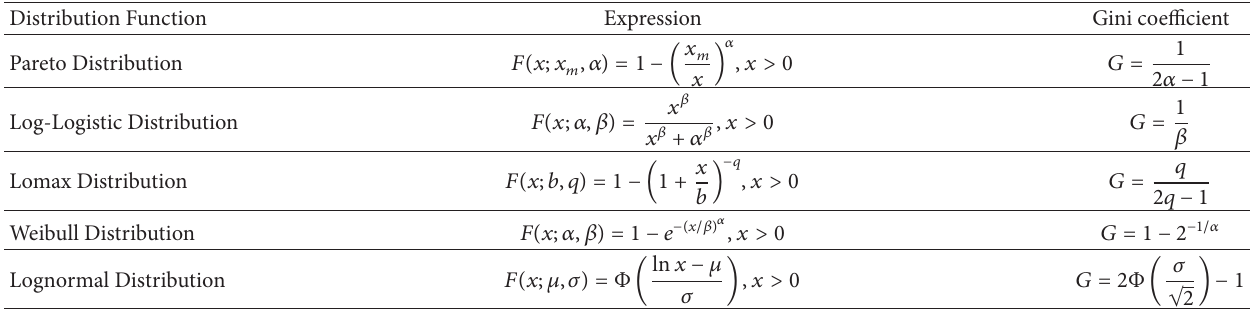
Table 1: Five Distribution Functions and respective expressions of Gini